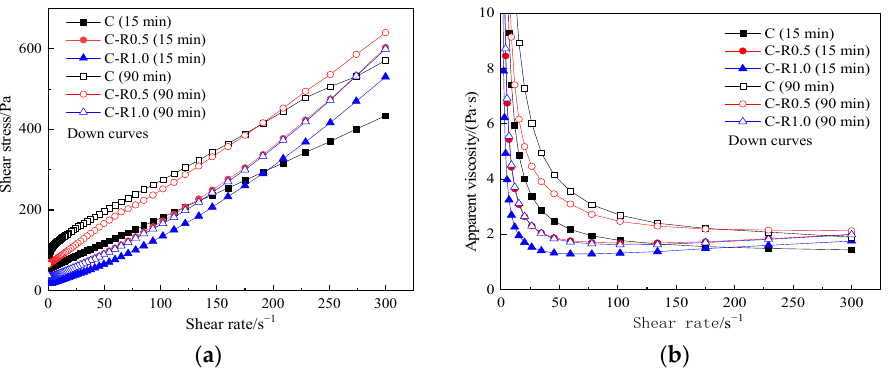
Figure 7. Rheological curves of C-RPP pastes. ( a ) shear stress vs. shear rate, ( b ) apparent viscosity vs. shear rate.